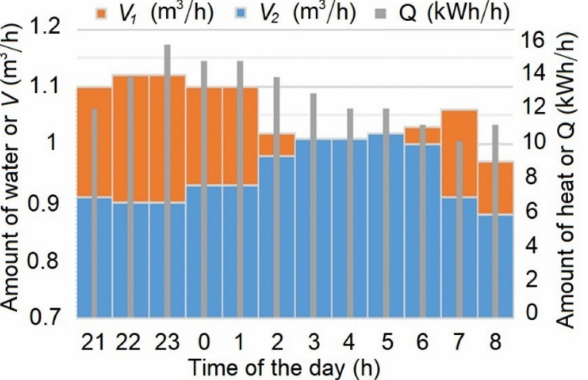
Figure 7. Hourly hot water supply V 1 to the consumer; hourly water return V 2 from the hydraulic circuit; hourly thermal energy Q generated by the gas-fired boiler at night (14–15 April